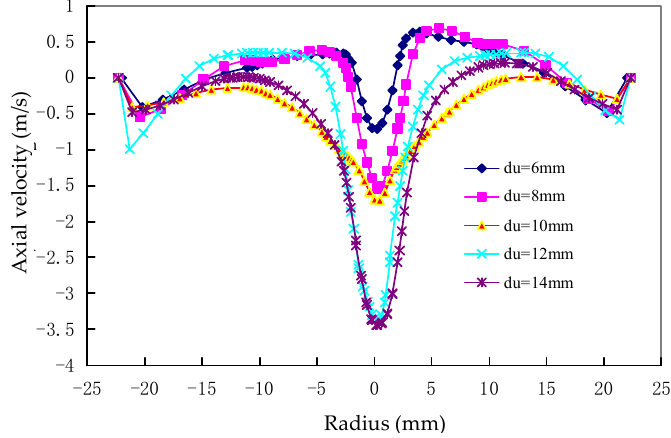
Figure 6. Axial velocity profiles at several underflow pipe diameters.